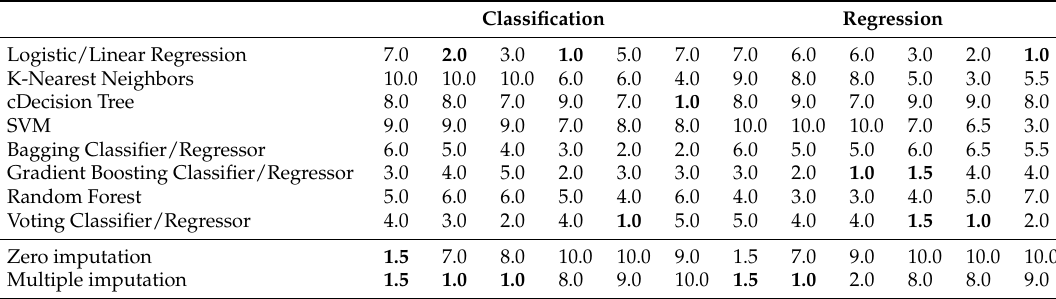
Table 16. Rankings of different classification and regression models for each subset for all